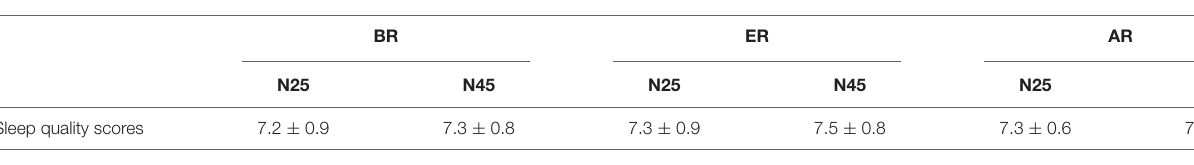
TABLE 2 | Sleep scale scores of each nap duration.